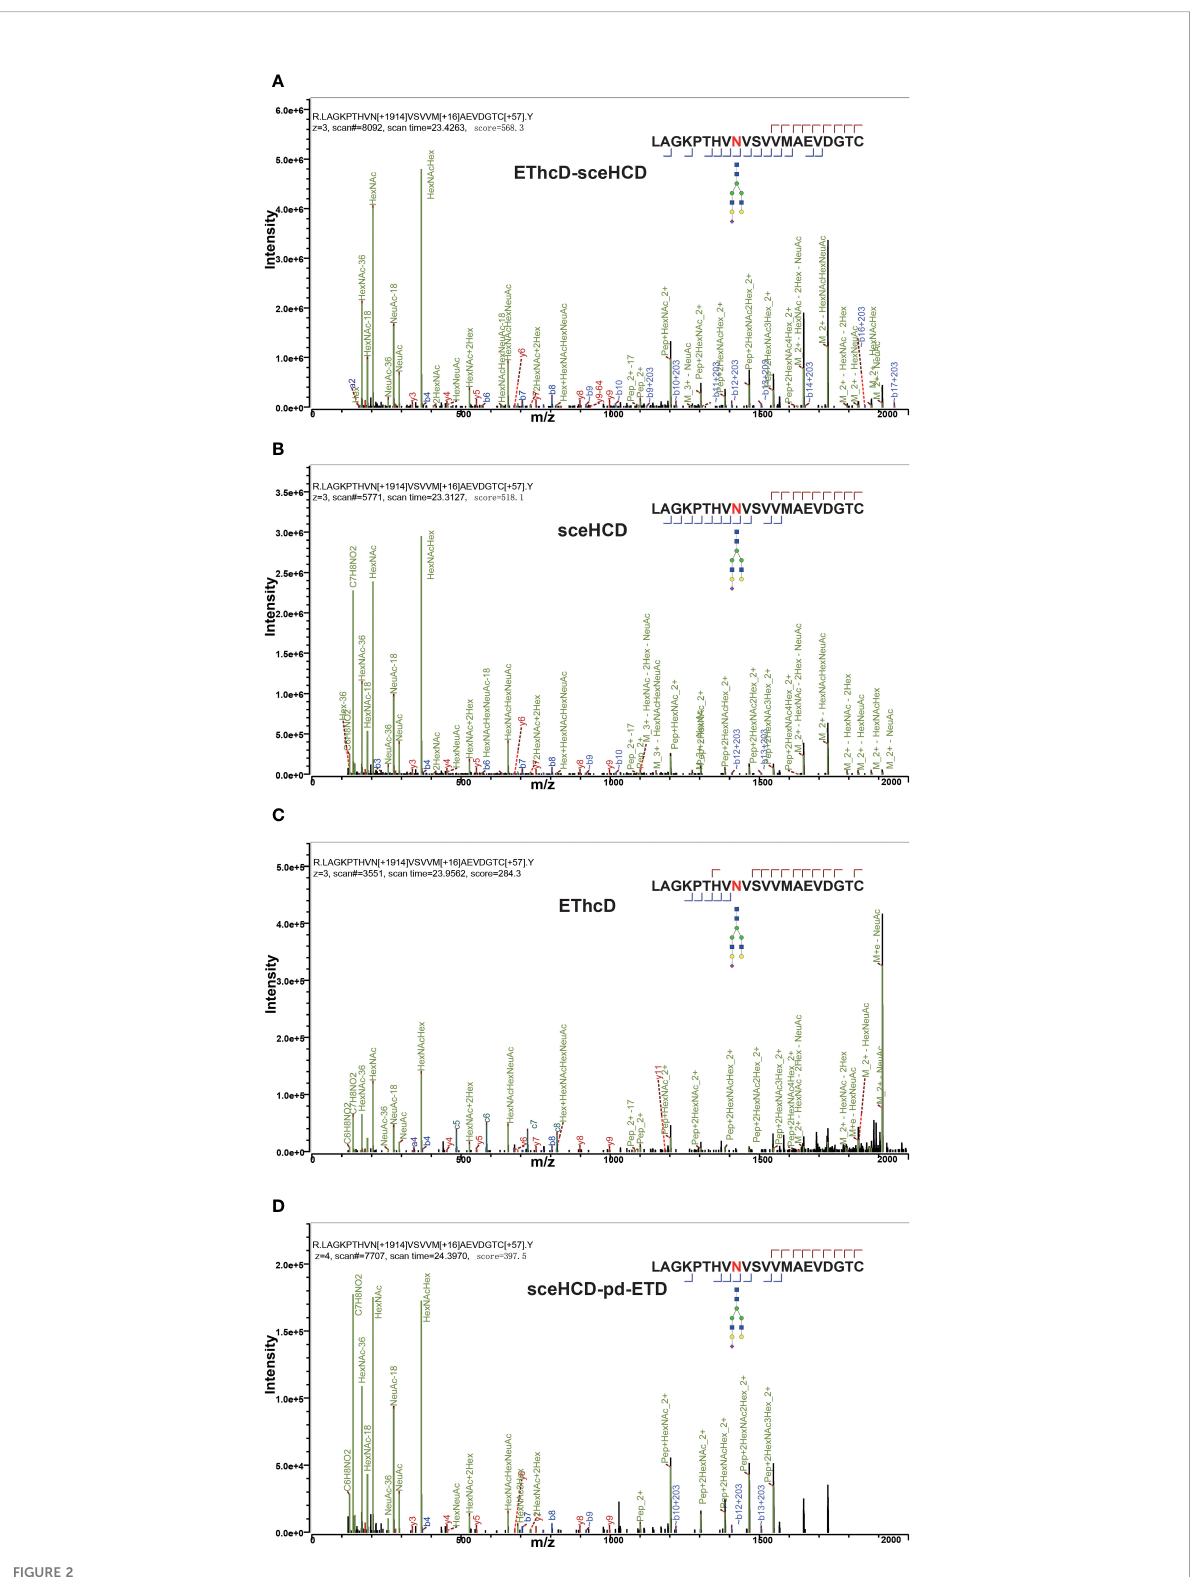
FIGURE 2 Comparison of EThcD-sceHCD (A) , sceHCD (B) , EThcD (C) , and sceHCD-pd-ETD (D) spectra of one intact N-glycopeptide ( 322 LAGKPTHV N VSVVMAEVDGTC 352 -HexNAc(4)Hex(5)NeuAc(1)) from serum monoclonal